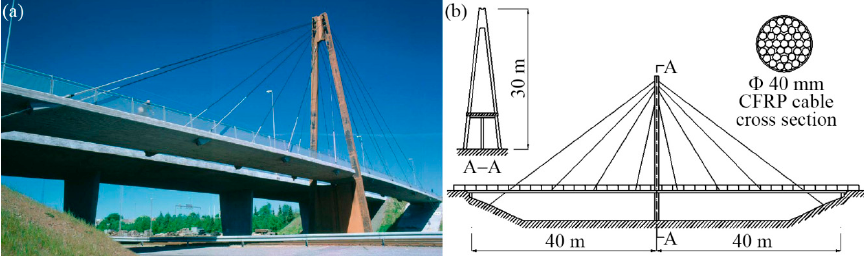
Figure 13. Herning CFRP Bridge, ( a ) photo (photo credit: COWI) and ( b ) sketch.